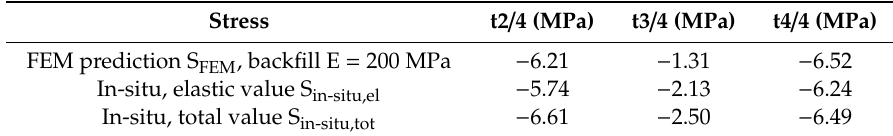
Table 5. Comparison of the in-situ measured and estimated by means of FEM (for the backfill, having E = 200 MPa) extreme stresses.